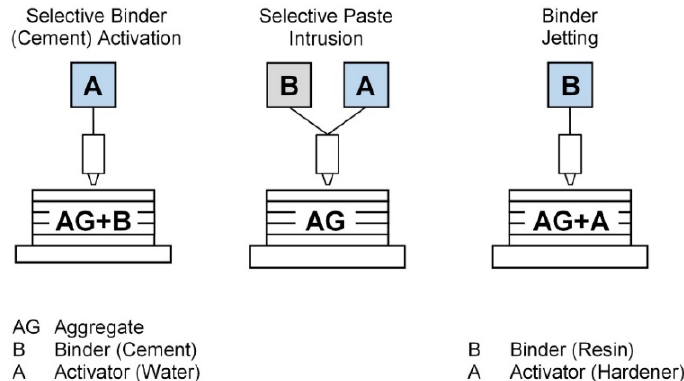
Figure 4. Particle bed AM processes in the construction industry [7] Copyright 2018 Copyright Elsevier Ltd.